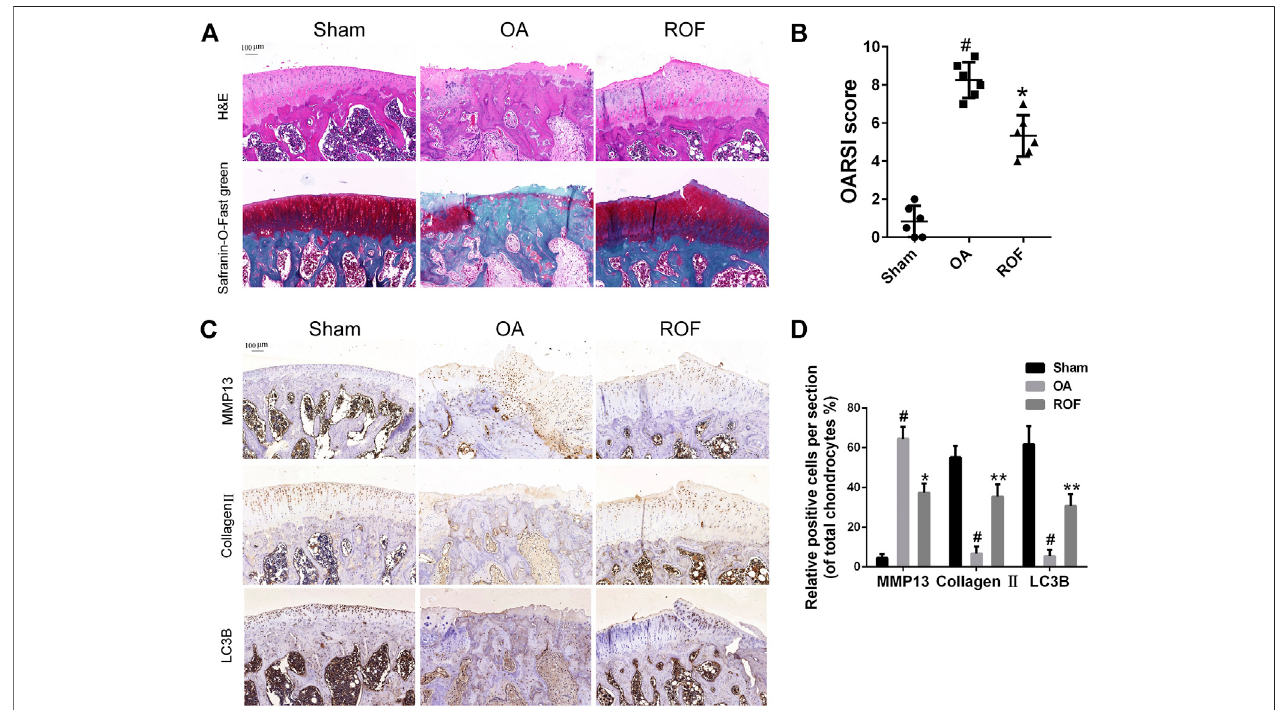
FIGURE6| ROFalleviatescartilagedamageintheratOAmodel. (A) H&EandSafranin-O-Fastgreenstainingofcartilagesamplesfromthreegroups8 weeksafter surgery. (B) OARIS scores of three groups. (C) Immunohistochemical staining and (D) quantitative analysis of MMP13, collagen Ⅱ , and LC3B in the cartilage samples fromthreegroups.Therateofpositivelystainedchondrocytesineachsectionwascalculatedandquantitatedfromsixratsofeachgroup.# p < 0.05vs.shamgroup;* p < 0.05 and ** p < 0.01 vs. OA